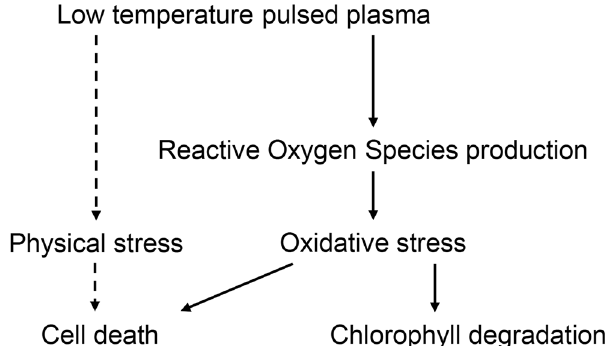
Figure 8. Proposed model for induced cell death in photosynthetic organs by plasma treatment. Low temperature pulsed plasma induce ROS accumulation in every tissue (solid arrow) and direct damage in epidermis (dotted arrow). ROS accumulation induce cell death and chlorophyll disruption, while direct damage in epidermis induce epidermis cell to be disrupted and ROS leaked from epidermis might contribute to ROS accumulation in